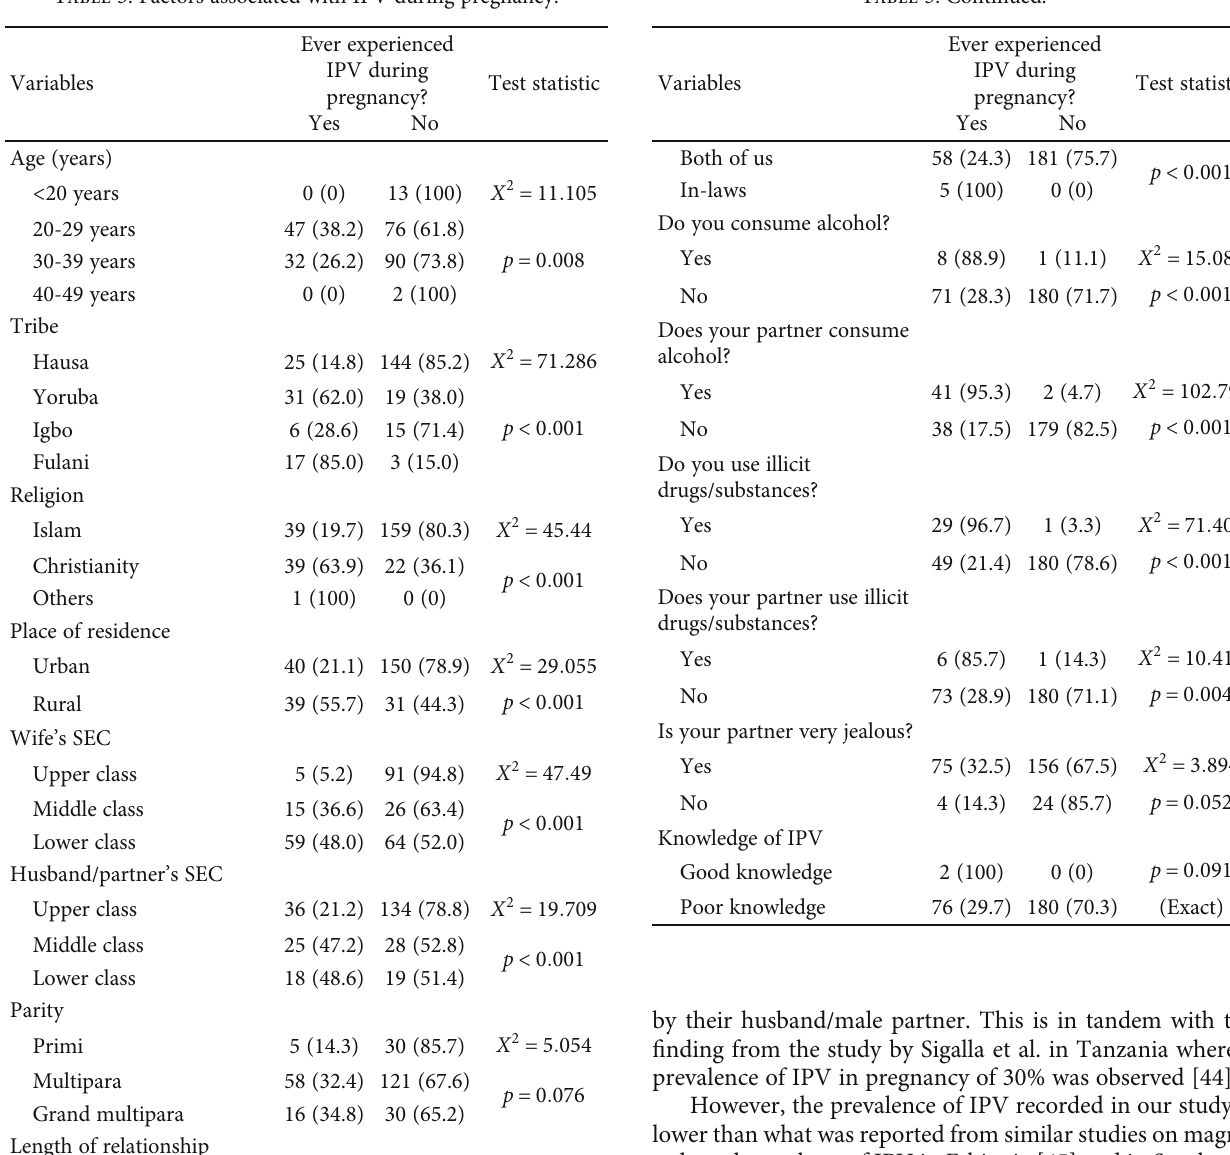
Table 5: Factors associated with IPV during pregnancy. Table 5: